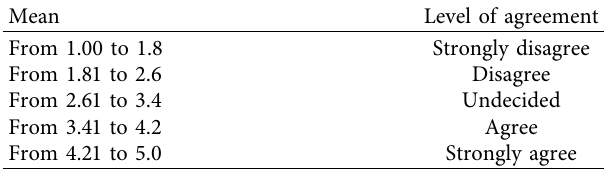
Table 1: Mean score range for fve-scale Likert’s response. Mean Level of